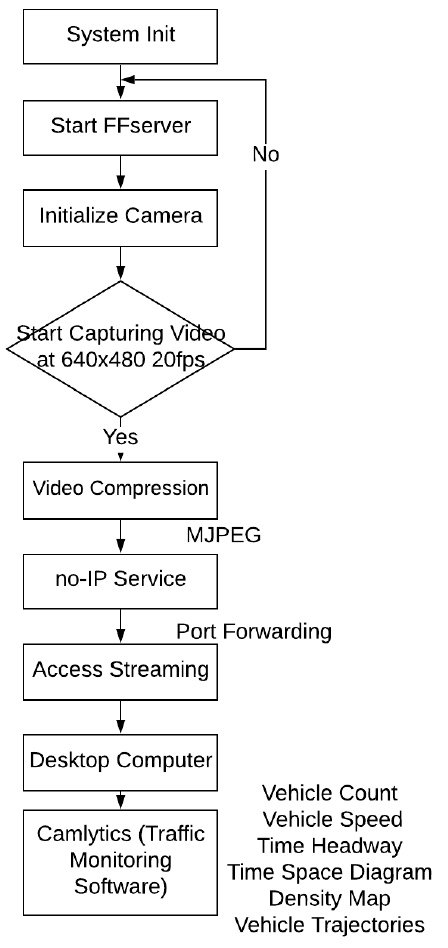
Figure 3. Software flow diagram of the proposed IoVT solution.